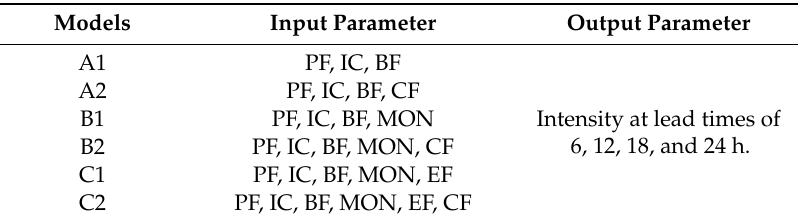
Table 7. List of test cases with